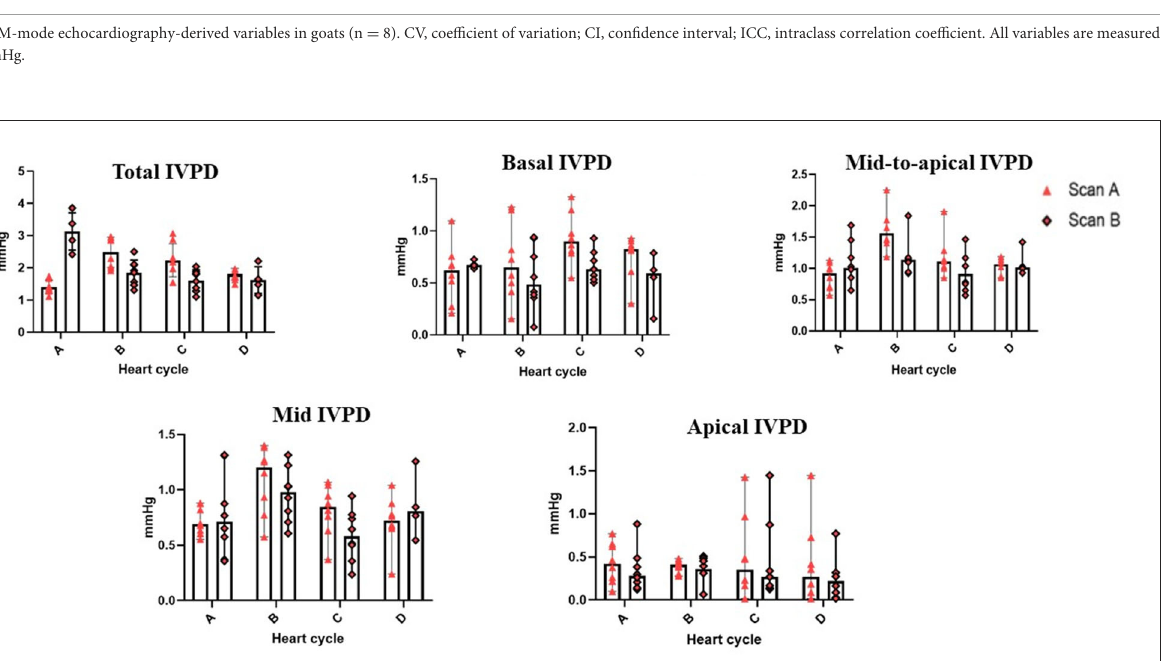
with a large effect size on total IVPD, basal IVPD, mid-to-apical IVPD, and mid-IVPD (rc: 1.0, 0.889, 1.0, 1.0, respectively) as well as total IVPG, basal IVPG, and mid IVPG (rc: 0.94,